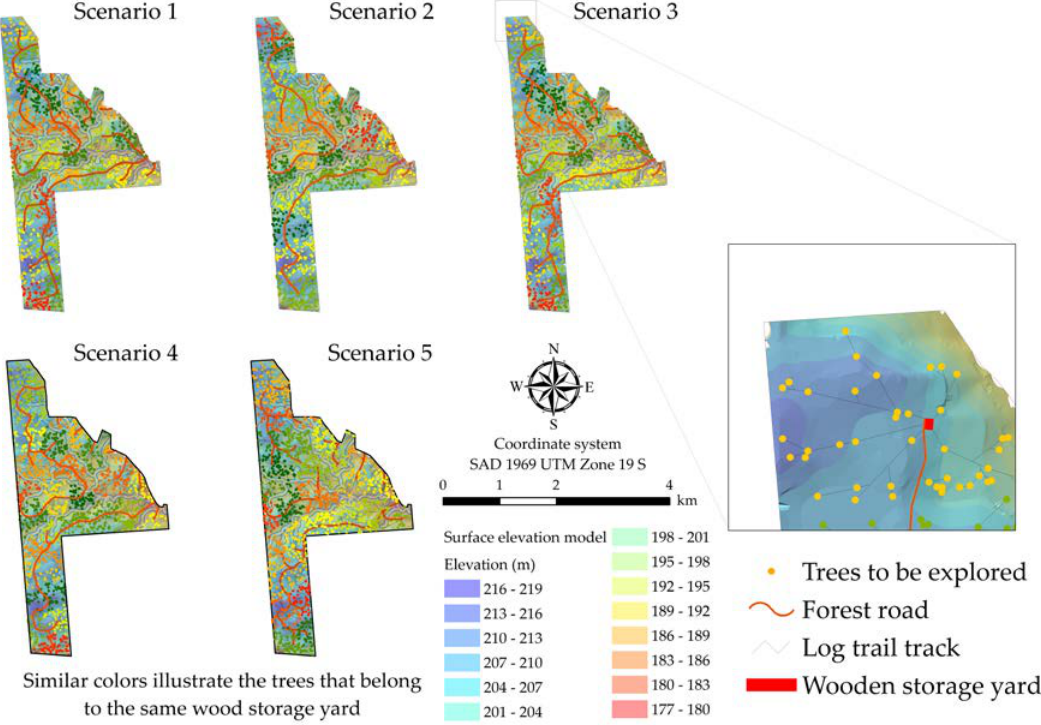
Figure 5. Forest road planning and skid trails of the evaluated scenarios.